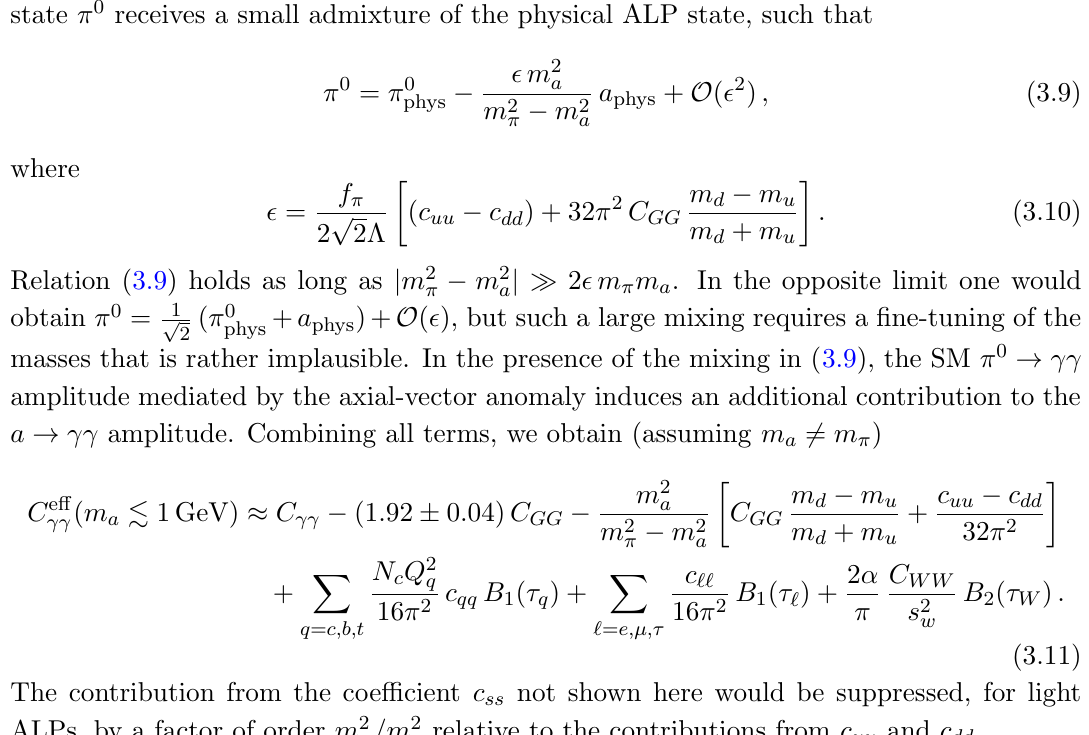
Figure 2 . Representative one-loop Feynman diagrams contributing to the decay a ‘ + ‘ (cid:0) . ! neutral pion. The physical states are obtained by bringing the kinetic terms into canonical form and rediagonalizing the mass matrix. This changes the mass eigenvalues for (cid:25) 0 and a by tiny corrections of order f 2 = (cid:3) 2 relative to the leading terms. At the same time, the (cid:25) state (cid:25) 0 receives a small admixture of the physical ALP state, such